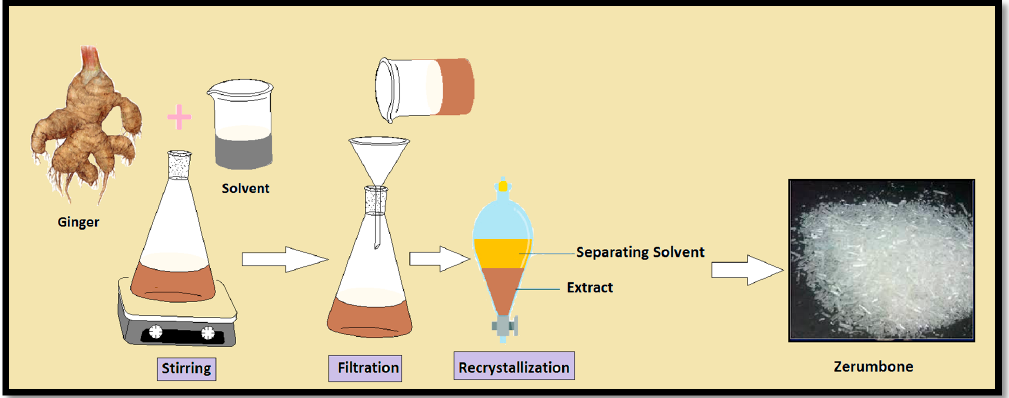
Figure 3. Separation process in solvent extraction.